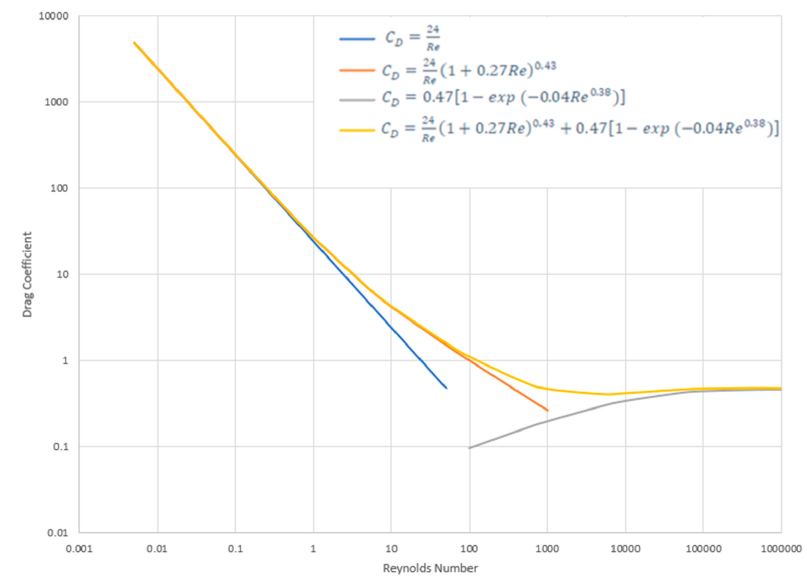
Figure 2. Coefficient of Drag and Reynolds Number Correlation (Adapted from Cheng [30]).